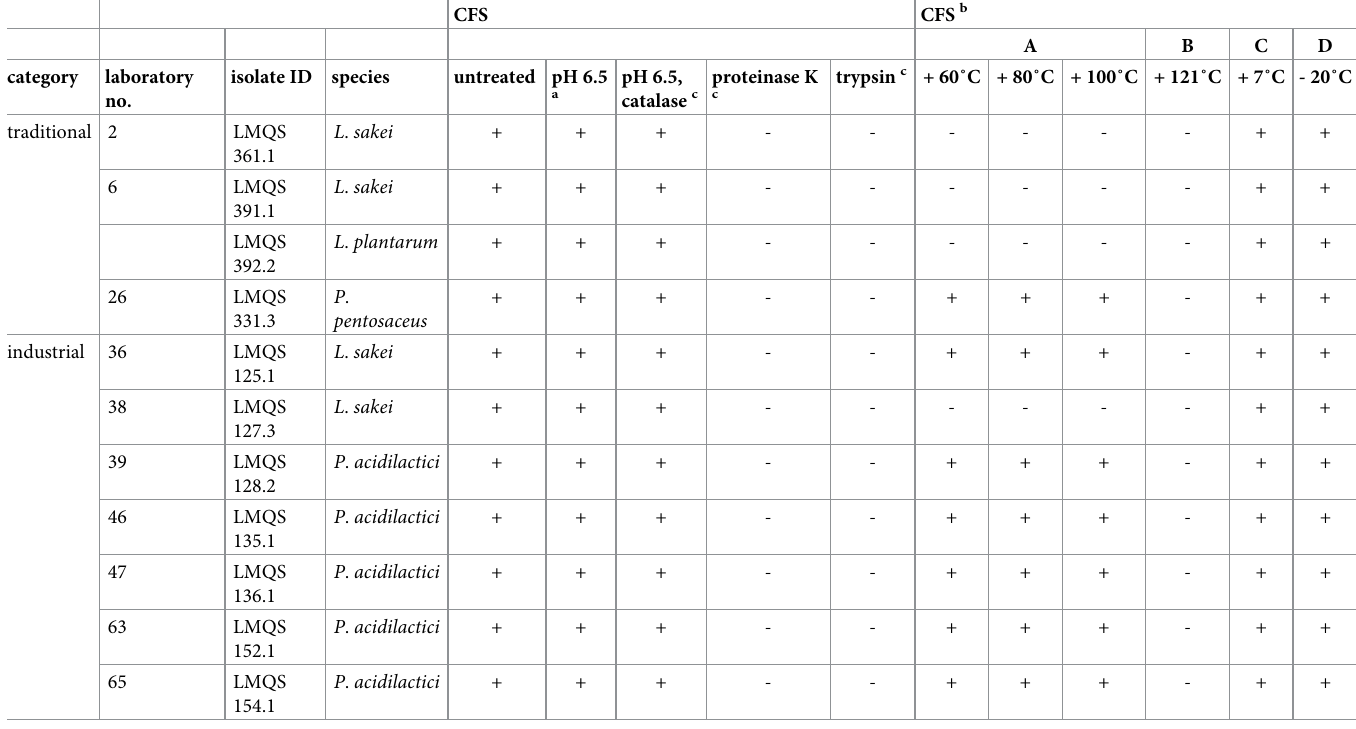
Table 3. Characterization of the mode of antibacterial activity against Listeria monocytogenes DSM 19094 and Listeria innocua DSM